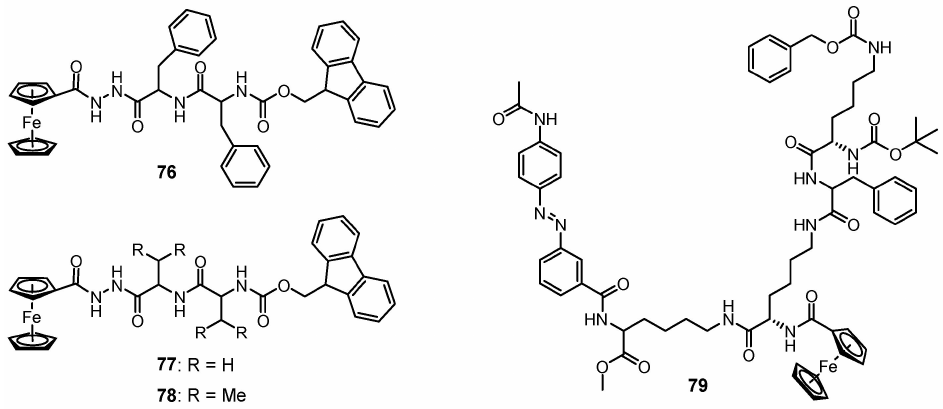
Figure 31. Chemical structures of 76 – 79 .